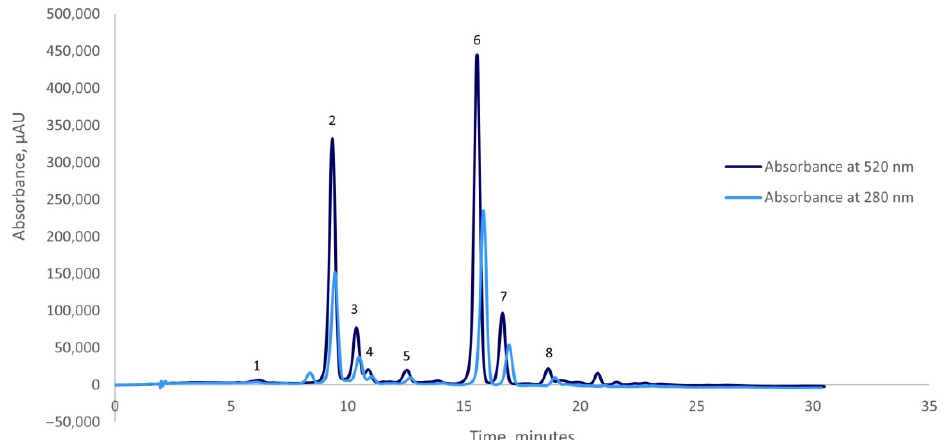
Figure 1. Chromatographic profile of the anthocyanins from the red onion skins extract obtained by ultrasounds-assisted extraction: Peak (1) cyanidin 3- O -glucoside; Peak (2) cyanidin 3- O -laminaribioside; Peak (3) cyanidin 3- O -(3 (cid:48)(cid:48) -malonylglucoside); Peak (4) peonidin 3- O -glucoside; Peak (5) cyanidin 3- O -(6 (cid:48)(cid:48) -malonylglucoside); Peak (6) cyanidin 3- O -(6 (cid:48)(cid:48) -malonyl-laminaribioside); Peak (7) peonidin 3- O -malonylglucoside and Peak (8) cyanidin